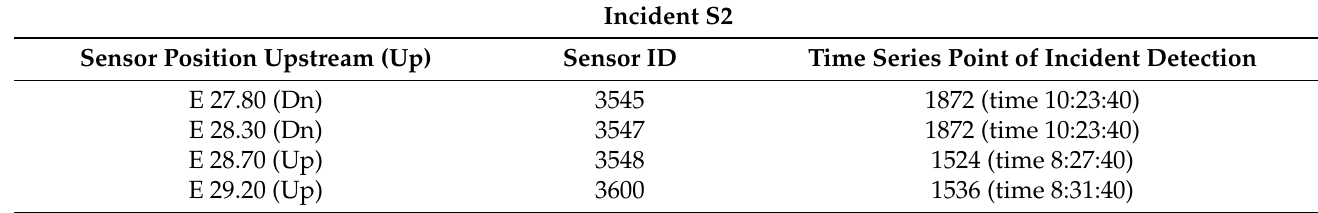
Table 3. Incident S2 (position: E 28.6, true time point index: 1587, true time 8:48:40): The detection results obtained by each sensor using the previous phase space reconstruction–based method